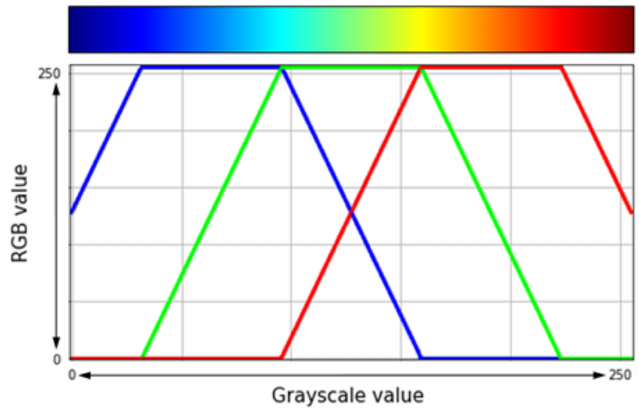
Figure 15. Examples of color maps suitable for thermal imaging.